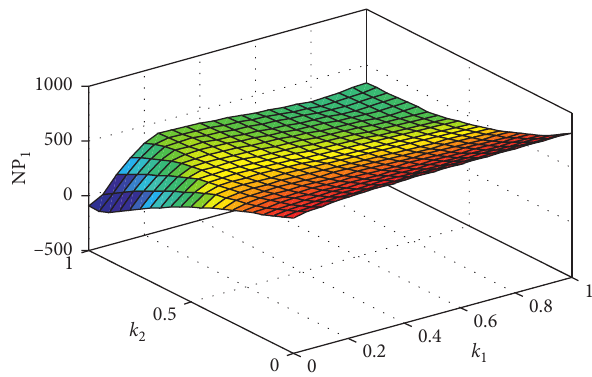
Figure 6: Relationship between the design enterprise’s profit NP and the fairness concern behavior of both parties.